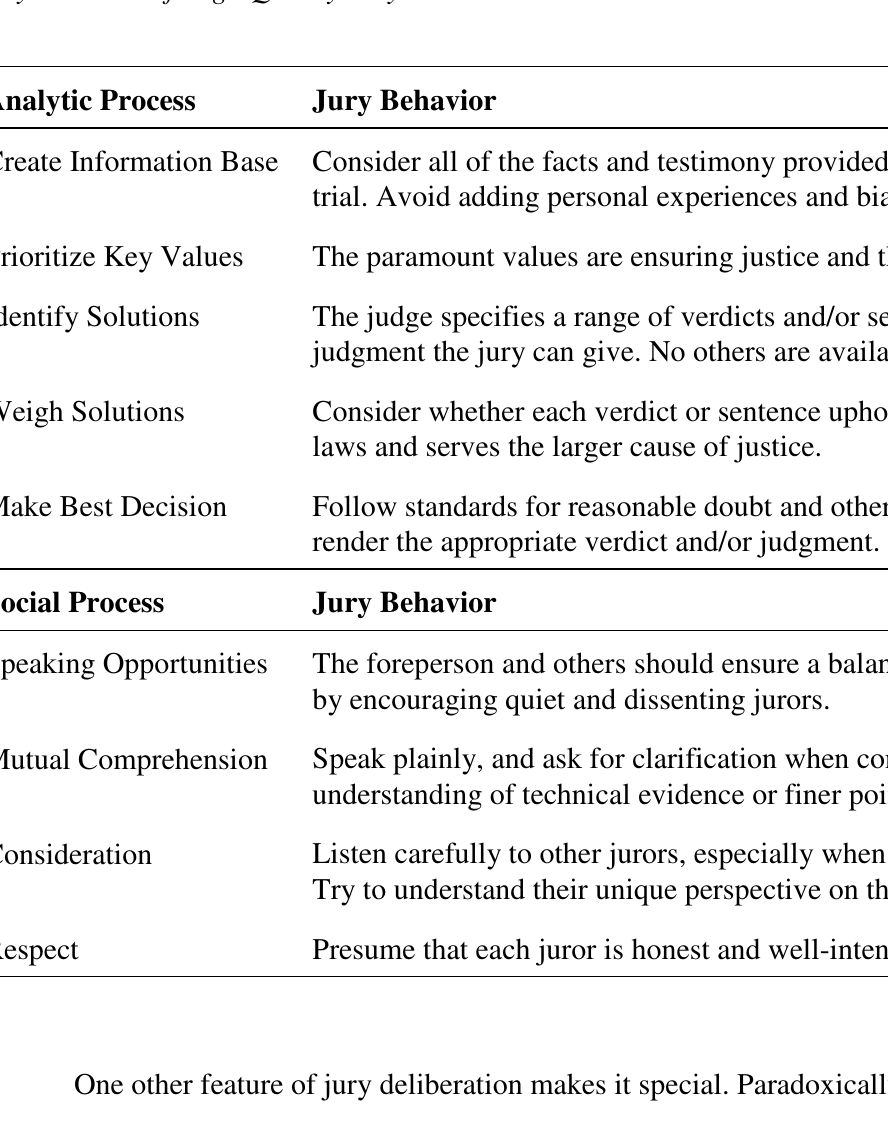
Key Features of High Quality Jury Deliberation